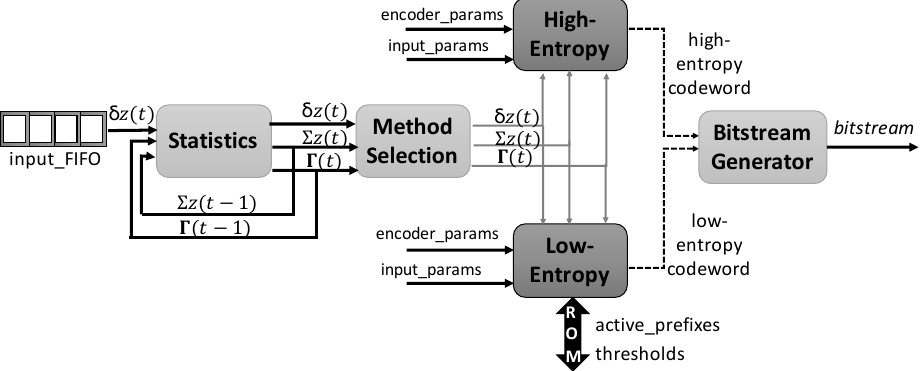
Figure 5. General overview of the hybrid encoder